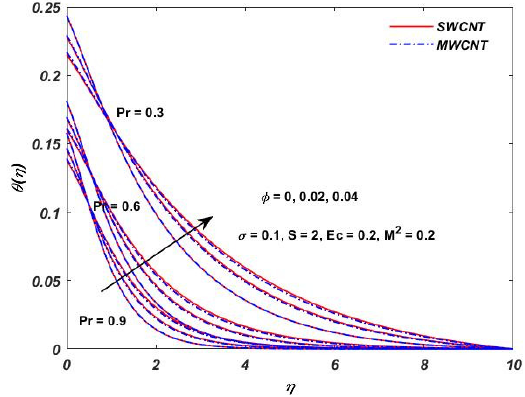
Figure 8. Prandtl (Pr) verses 𝜃(𝜂).